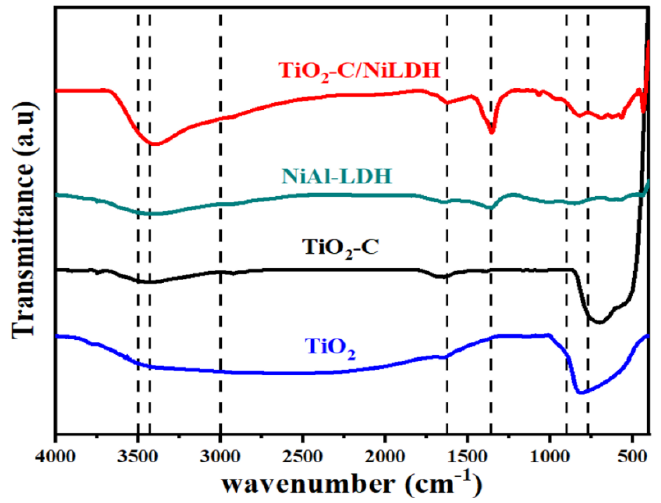
Figure 1. FT-IR spectra of TiO 2 , TiO 2 -C, NiAl-LDH, and TiO 2 -C/NiLDH amalgam samples.